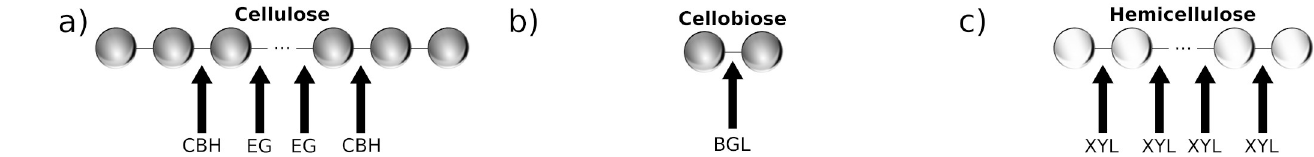
Fig 3. Schematic representation of the polymer bonds that can be digested within the model. (a) Cellulose digestion sites by endoglucanase (EG) and cellobiohydrolase (CBH). Endoglucanase may digest glucose-glucose bonds along the entire polymer, except for the two outermost bonds at each end. Cellobiohydrolase processively cuts off cellobiose from either polymer ends. (b) Cellobiose digestion site by β -glucosidase (BGL). β -glucosidase exclusively digests cellobiose into two glucose molecules. (c) Hemicellulose digestion sites by xylanase (XYL). Xylanase may digest xylose-xylose bonds at any position along the hemicellulose